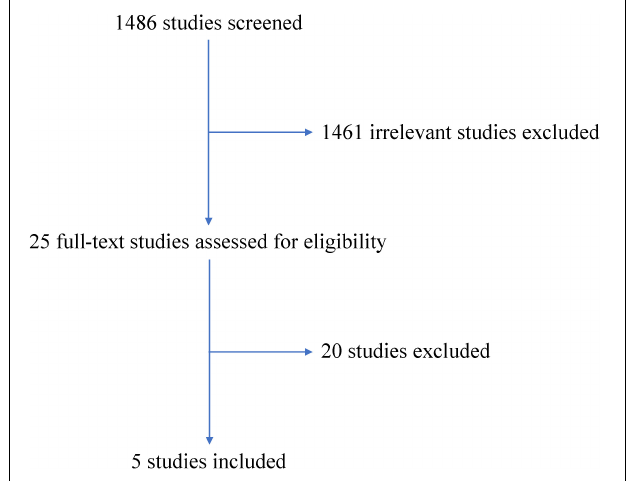
FIGURE 1 | Flowchart of literature